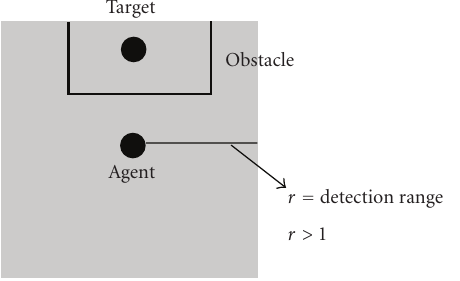
Figure 1: Target is detected within range.